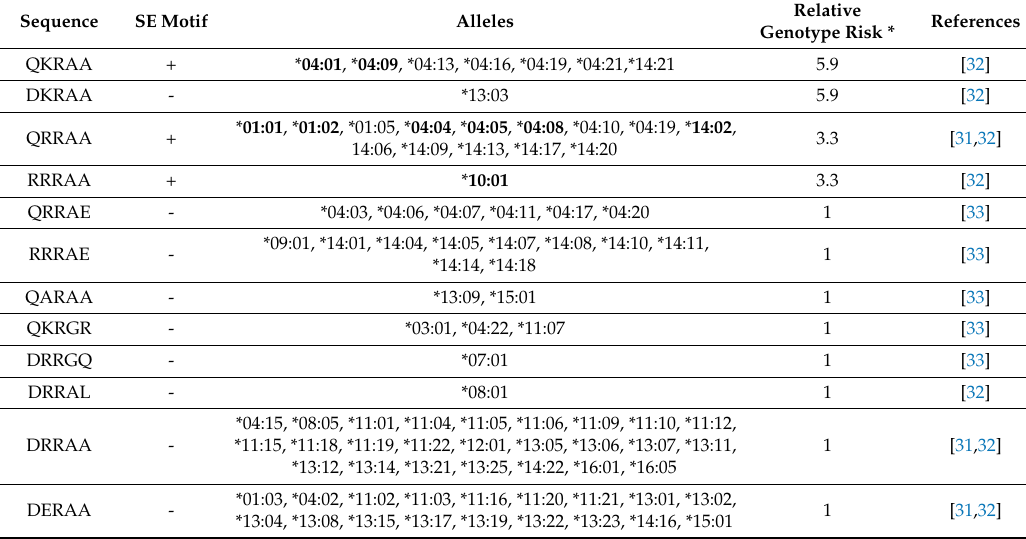
Table 1. Classification of HLA-DRB1 alleles and their role relative to onset of rheumatoid arthritis. Highlighted alleles constitute the most frequently reported alleles associated with rheumatoid arthritis. The risk of developing rheumatoid arthritis is among others associated with the presence of specific amino acids in the amino acid positions 70–74. Crucial is the RAA motif in positions 72–74, but the effect is modulated by the amino acids in positions 71 and 70 as well, where K in position 71 confers the highest risk, R an intermediate risk, and A and E a lower risk. Similarly, the amino acids Q and R in position 70 confer a higher risk than D. Bold alleles represent the most common alleles detected in individuals with rheumatoid